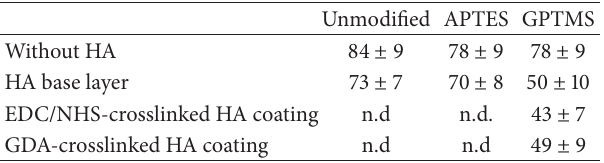
Table 1: Contact angles of the modified planar PA12 surfaces ( 𝑛 = 5 ) in preparation for and after chemical attachment of the HA base layer and after deposition of crosslinked HA coatings. Data shown as mean ±